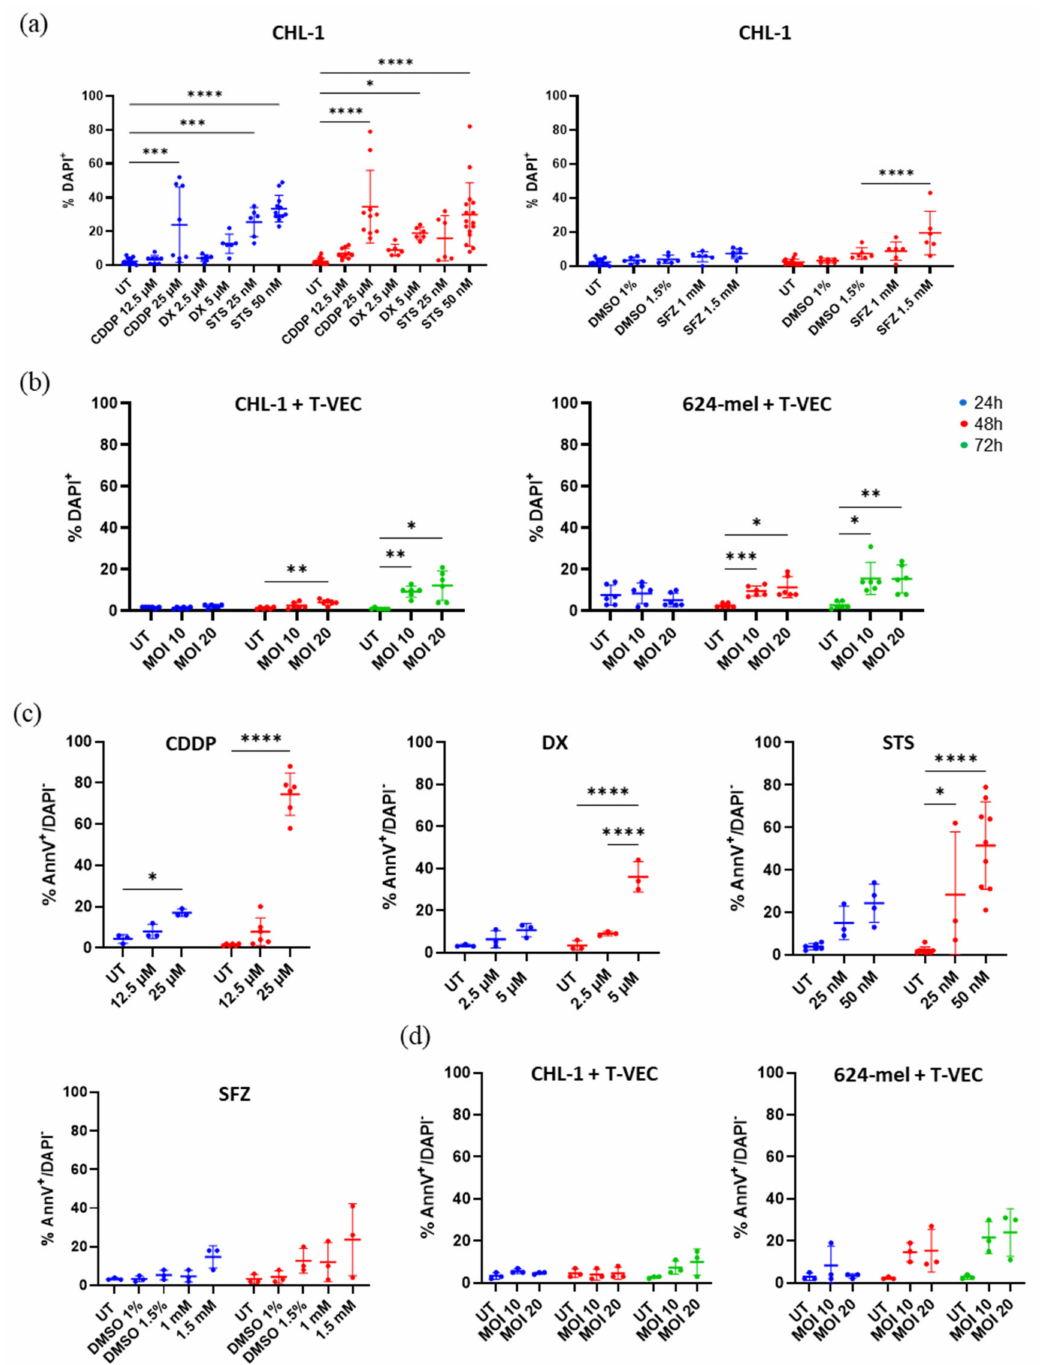
Figure 1. Cell viability and exposure of PS in response to various treatments. ( a , b ) CHL-1 cells were treated with CDDP, DX, STS, SFZ or T-VEC for up to 72 h. The amount of dead cells (DAPI positive) was determined by means of flow cytometry. ( c ) CHL-1 cells were treated with CDDP, DX, STS or SFZ for up to 48 h. ( d ) CHL-1 or 624-mel cells were treated with T-VEC for up to 72 h. Exposure of PS within the DAPI negative population was determined by means of flow cytometry. Data displays at least three repeats of independent experiments. Data were analyzed with two-way ANOVA or mixed model with Šid á k corrections. * p < 0.05; ** p < 0.01, *** p < 0.001 and **** p < 0.0001 Abbreviations: CDDP: cisplatin; DMSO: dimethyl sulfoxide; DX: doxorubicin; MOI: multiplicity of infection; PS: phosphatidyl serine; SFZ: sulfasalazine; STS: staurosporine; T-VEC: Talimogene laherparepvec; UT: